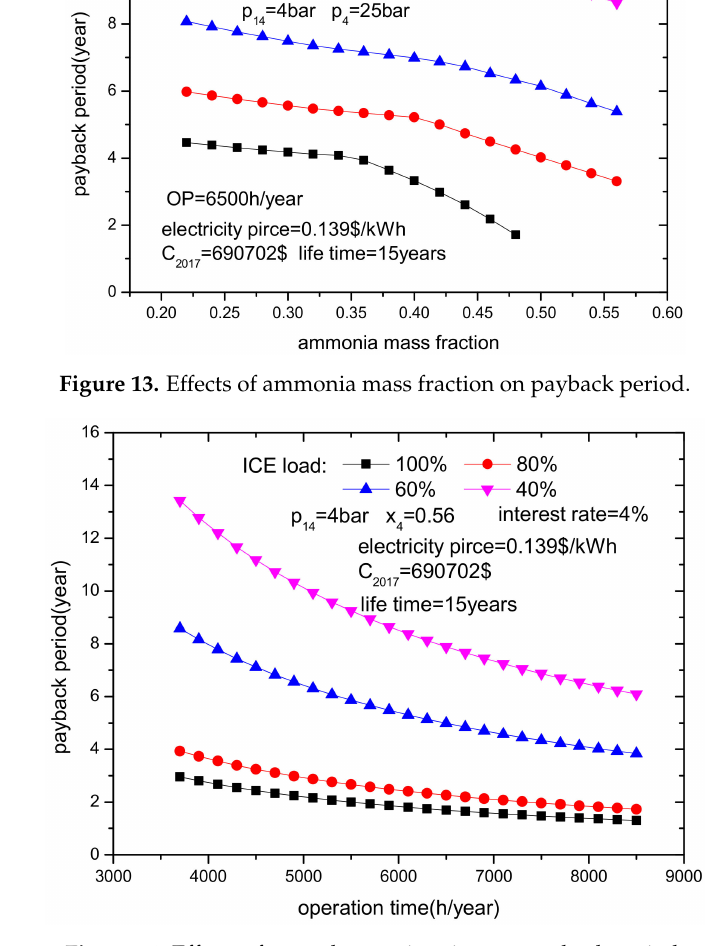
Figure 14. Effects of annual operation time on payback